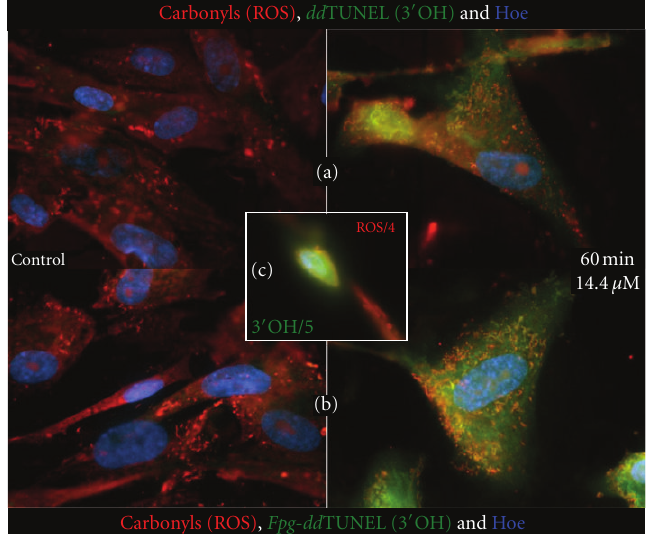
Figure 4: Colocalization of carbonyls and mtDNA damage normal human astrocytes. Thimerosal-induced oxidative damage occurs at mitochondrial matrix level. Nuclei (blue), carbonyls (red), and 3 (cid:3) OH DNA ends (green) in (a) and Fpg -labile DNA bases/apurinic and apyrimidinic sites (green) in (b). (c) (insert): A cell that has entered the final stages of apoptosis with large numbers of 3 (cid:3) OH DNA ends derived from nuclear